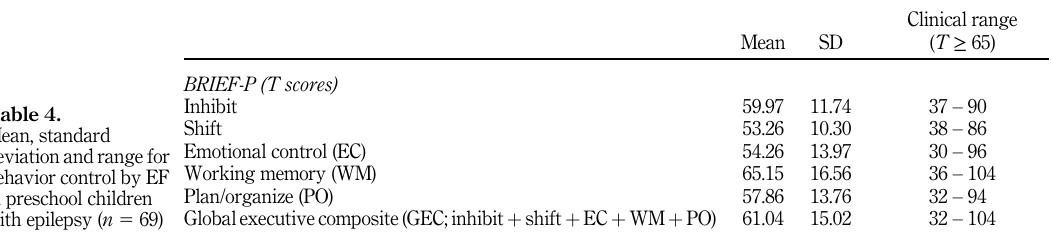
deviation and range for behavior control by EF in preschool children with epilepsy ( n 5